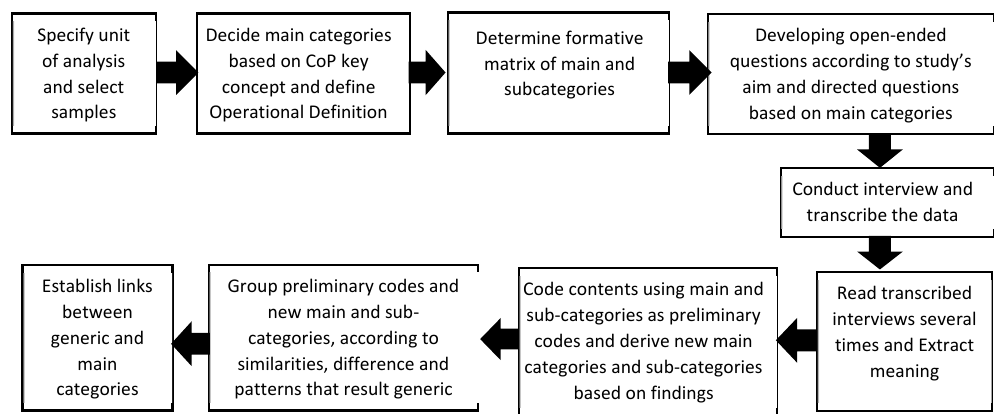
Fig. 3: Qualitative data analysis process using Directed QCA ( Assarroudi et al., 2018; Miles et al. , 2014